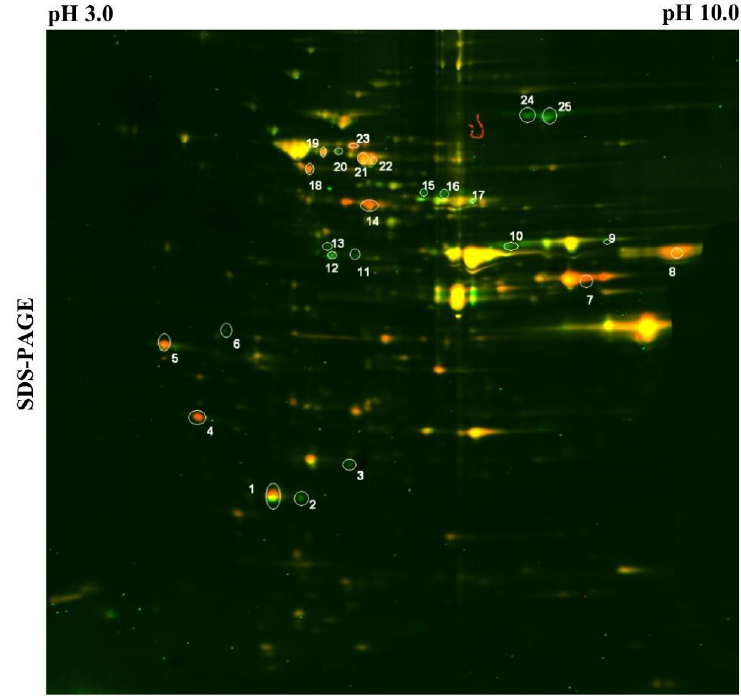
Figure 2. 2D-DIGE analysis of wild-type (green) and aim23Δ (red) strains’ proteins after 24 h of growth on YPEG. Spots sliced for identification are marked. Table 1. Identified proteins differentially expressed in wild-type and aim23Δ strains during adaptation to respiratory growth.